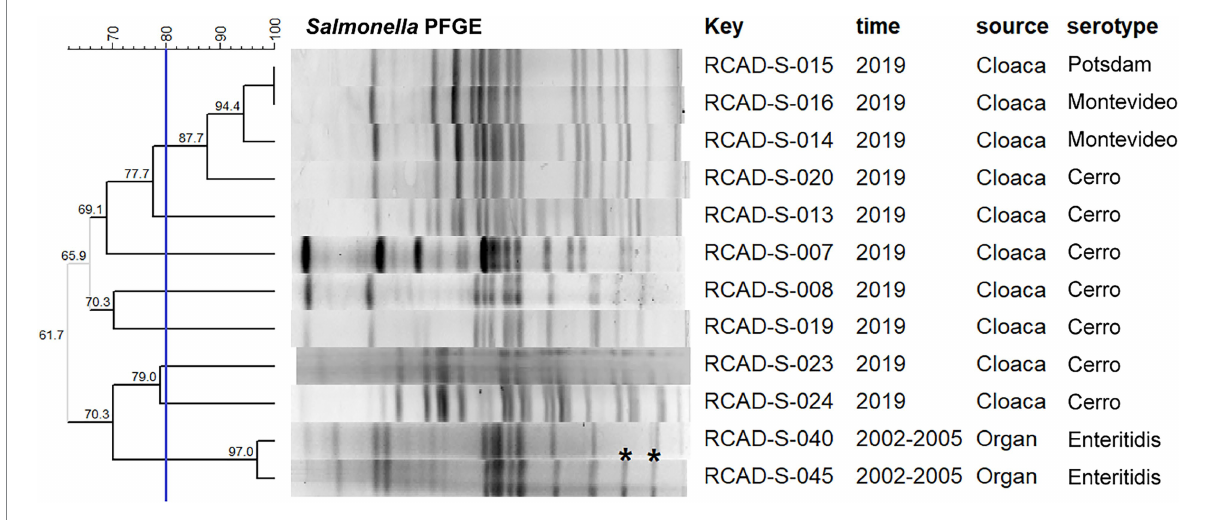
FIGURE 1 Dendrogram of the PFGE pulsotypes for 12 representative isolates. The blue line indicates the 80% cutoff value. The “key” column represents the different isolates; RCAD, Research Center of Avian Diseases. Asterisks indicate differences between adjacent bands.